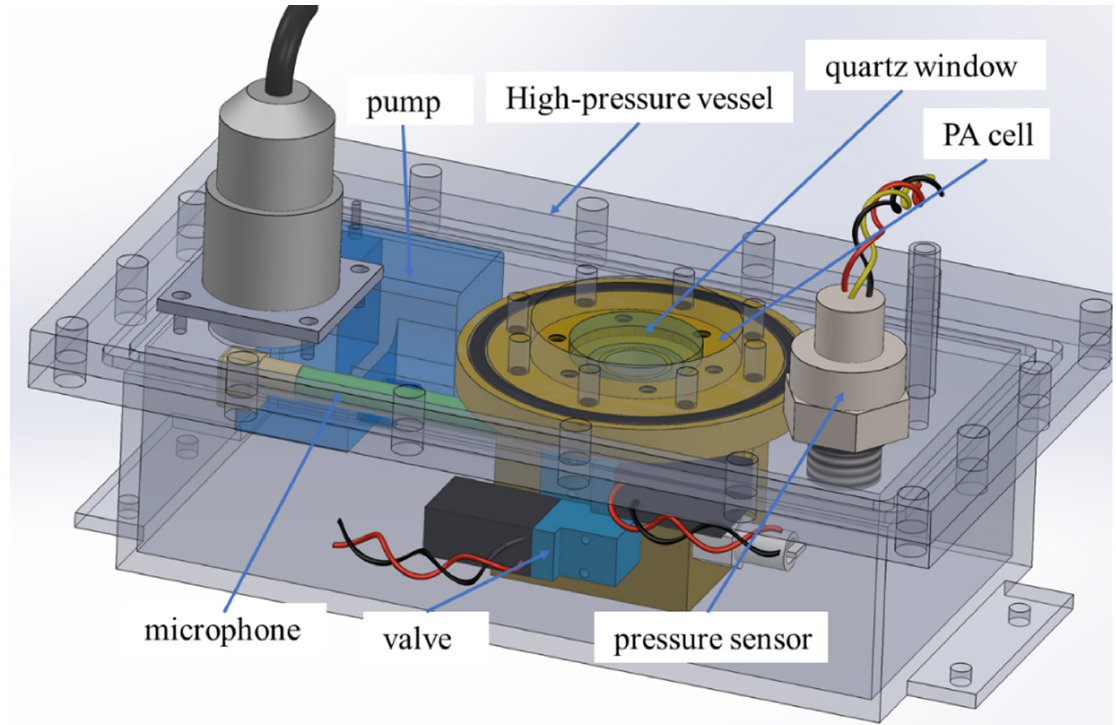
Figure 6. Three-dimensional model of the designed gas vessel and PA cell.